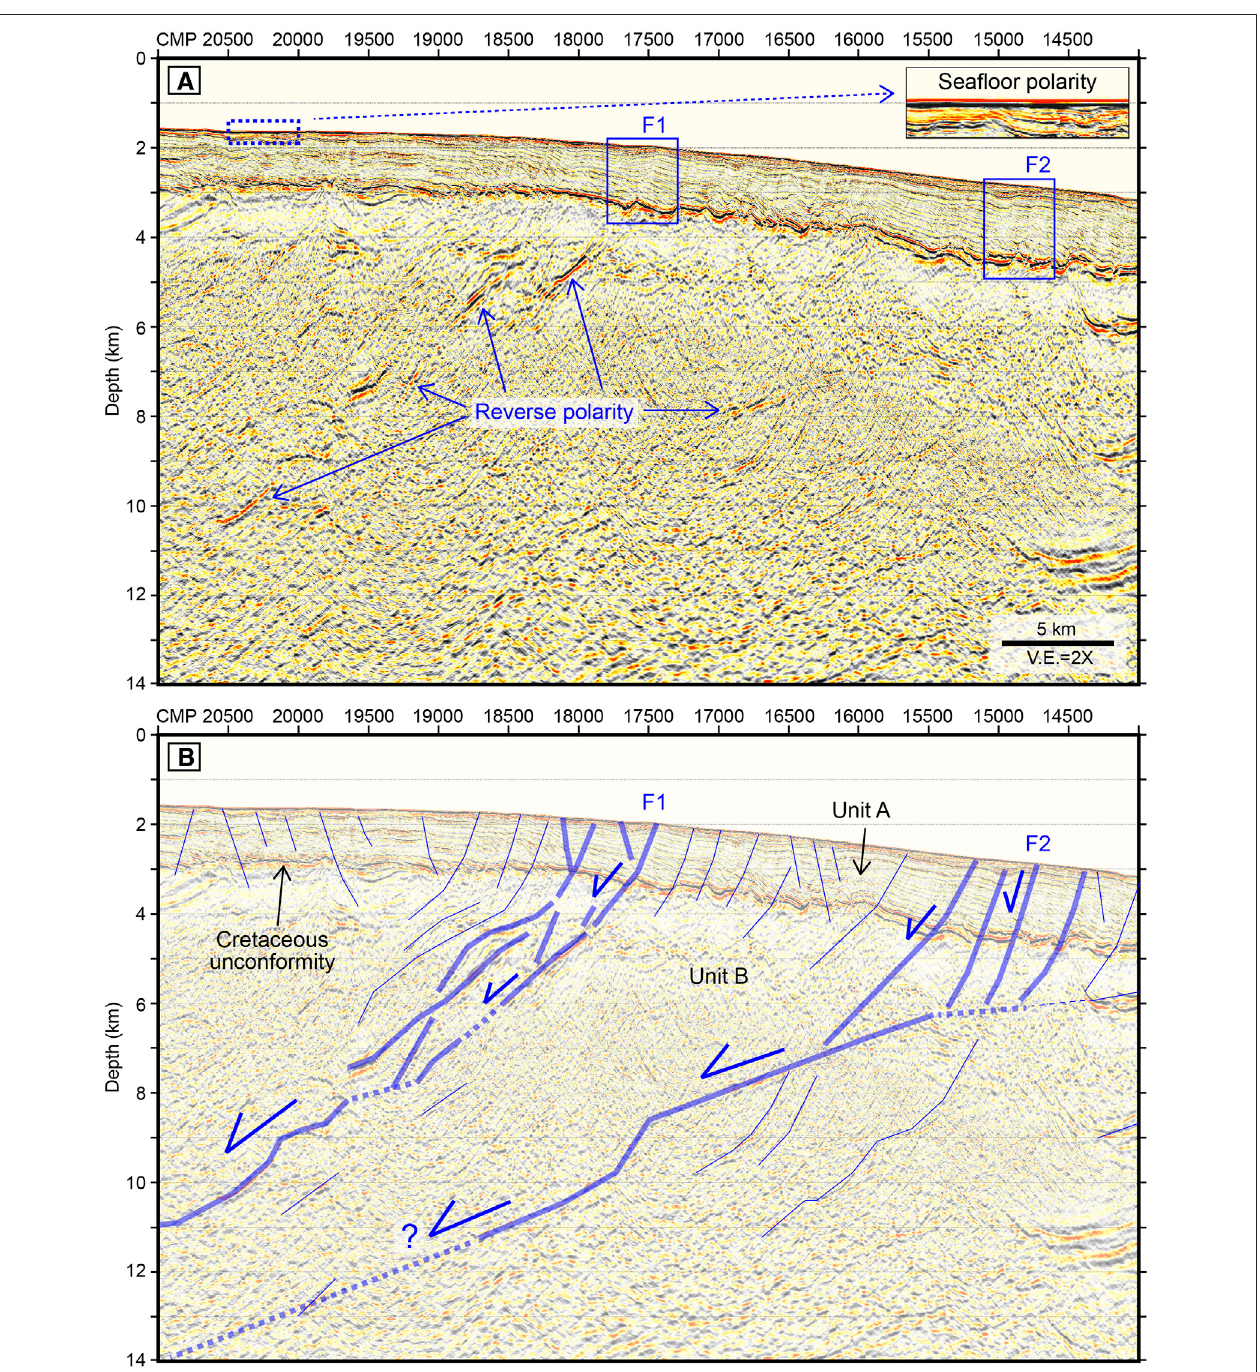
FIGURE 4 | Enlarged PSDM section on line D6 and its interpretation showing landward-dipping normal faults of F1 and F2 in the middle slope region. Location of the section is presented in Figure 2B . (A) Uninterpreted PSDM section. High-amplitude, reverse-polarity re fl ections (black – red – black) of the normal faults F1 and F2, compared with sea fl oor re fl ection (red – black – red), suggesting high pore pressure of the fault zones. Close-up fi gures (thin blue boxes) of the faults F1 and F2 at shallow depth are shown in Supplementary Figures S3A,B , respectively. (B) Interpreted PSDM section. Most normal faults cut down the Cretaceous erosional unconformity.